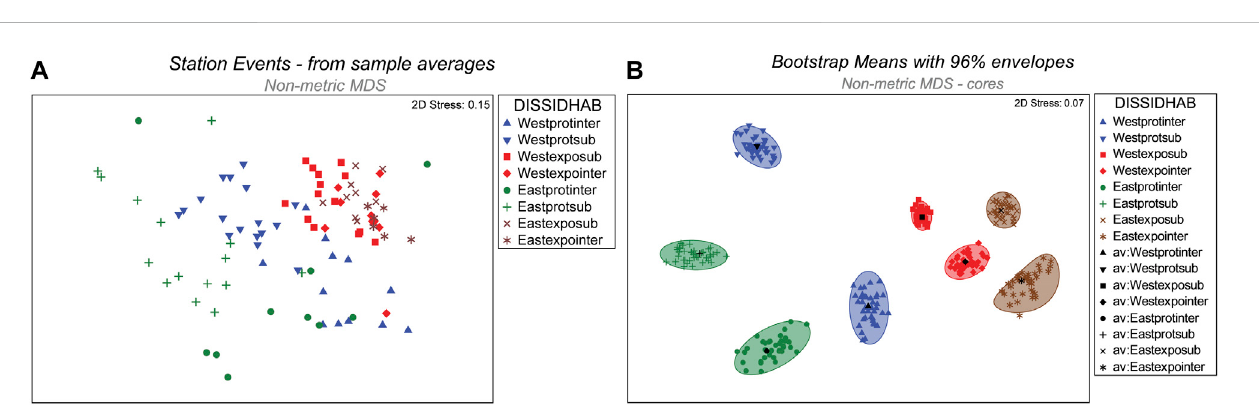
FIGURE 5 (A) Ordination of nMDS coordinates representing station events. Coordinates for the eight combinations of District, Shore side, and Habitat segregate within2-Dordinationspace. (B) .Plotsofgroupcentroidswith96%con fi denceenvelopesasdeterminedbybootstrapresamplingforeightcombinedlevelsof District,Side,andHabitat.(legendcodes:DISSIDHAB-District/Side/Habitat;West – westerndistrict;East-easterndistrict;prot – protectedsite;expo – exposed site; inter – intertidal habitat; sub – subtidal habitat; av, group